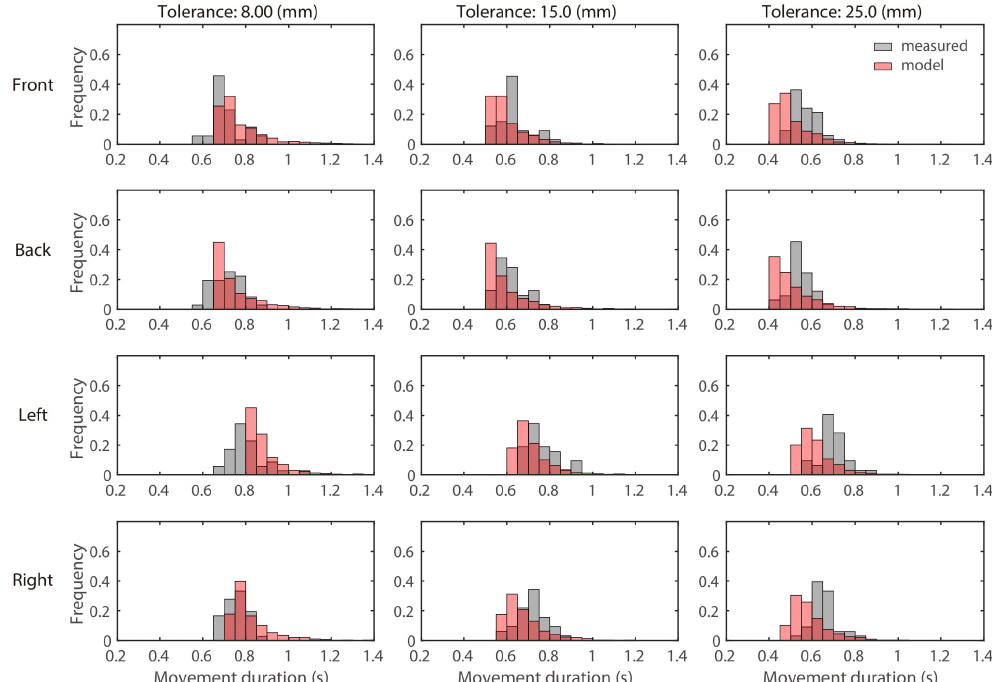
Figure 7. Comparison between the distributions of the measured and model movement durations. The results of a representative subject (subject A) are shown. The λ determined for each direction was used. The histograms are normalized such that the total height of all bars is 1.